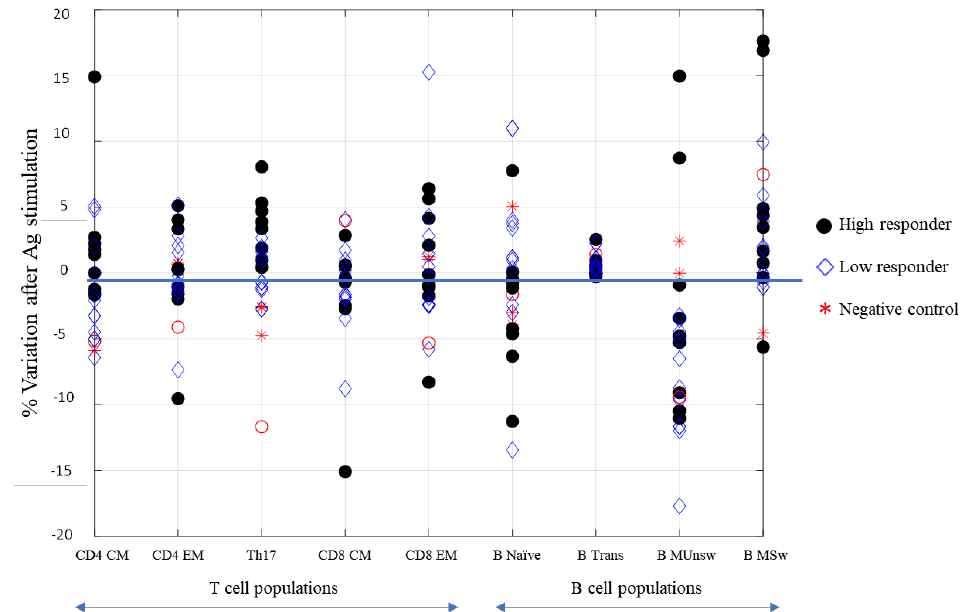
Figure 3. Representation of normalized parameters related to the immune cell populations with respect to their relative variations before and after stimulation with the SARS -CoV-2 Spike protein. High-responding subjects (black circles), low-responding ones (diamonds), and controls (stars). T cell populations: CD4 + CM (central memory, CD45RA − CCR7 + ), CD4 + EM (effector memory, CD45RA − CCR7 − ), CD4 + Th17 (CXCR3 − CCR6 + ), CD8 + CM (central memory, CD45RA − CCR7 + ), CD8 + EM (effector memory, CD45RA − CCR7 − ). B-cell populations: B naïve (CD19 + CD27 − IgD + ), B transitional (CD19 + CD27 − IgD + CD24 high CD38 high ), B MUnsw (memory unswitched CD19 + CD27 + IgD + ), and B MSw (memory switched CD19 + CD27 + IgD − ).